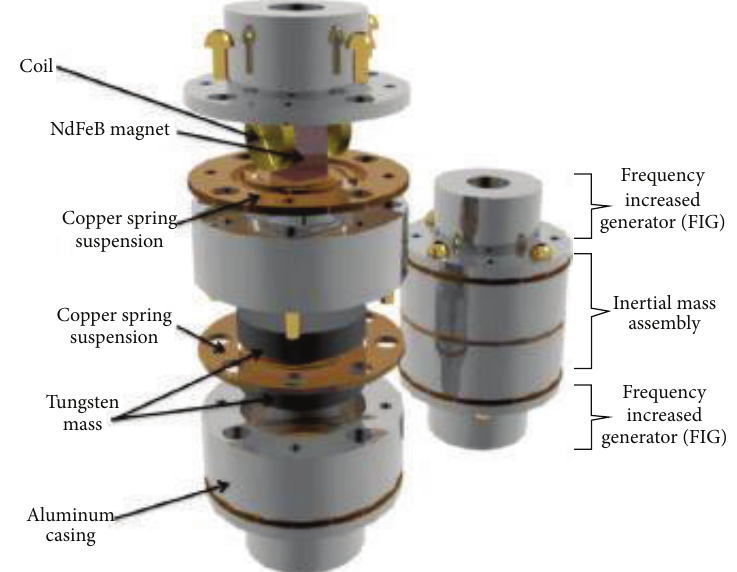
Figure 10: Exploded view of EM-VEH